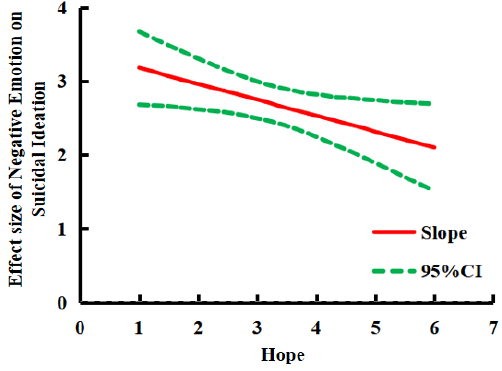
Figure 3. The trajectory of simple slope change.